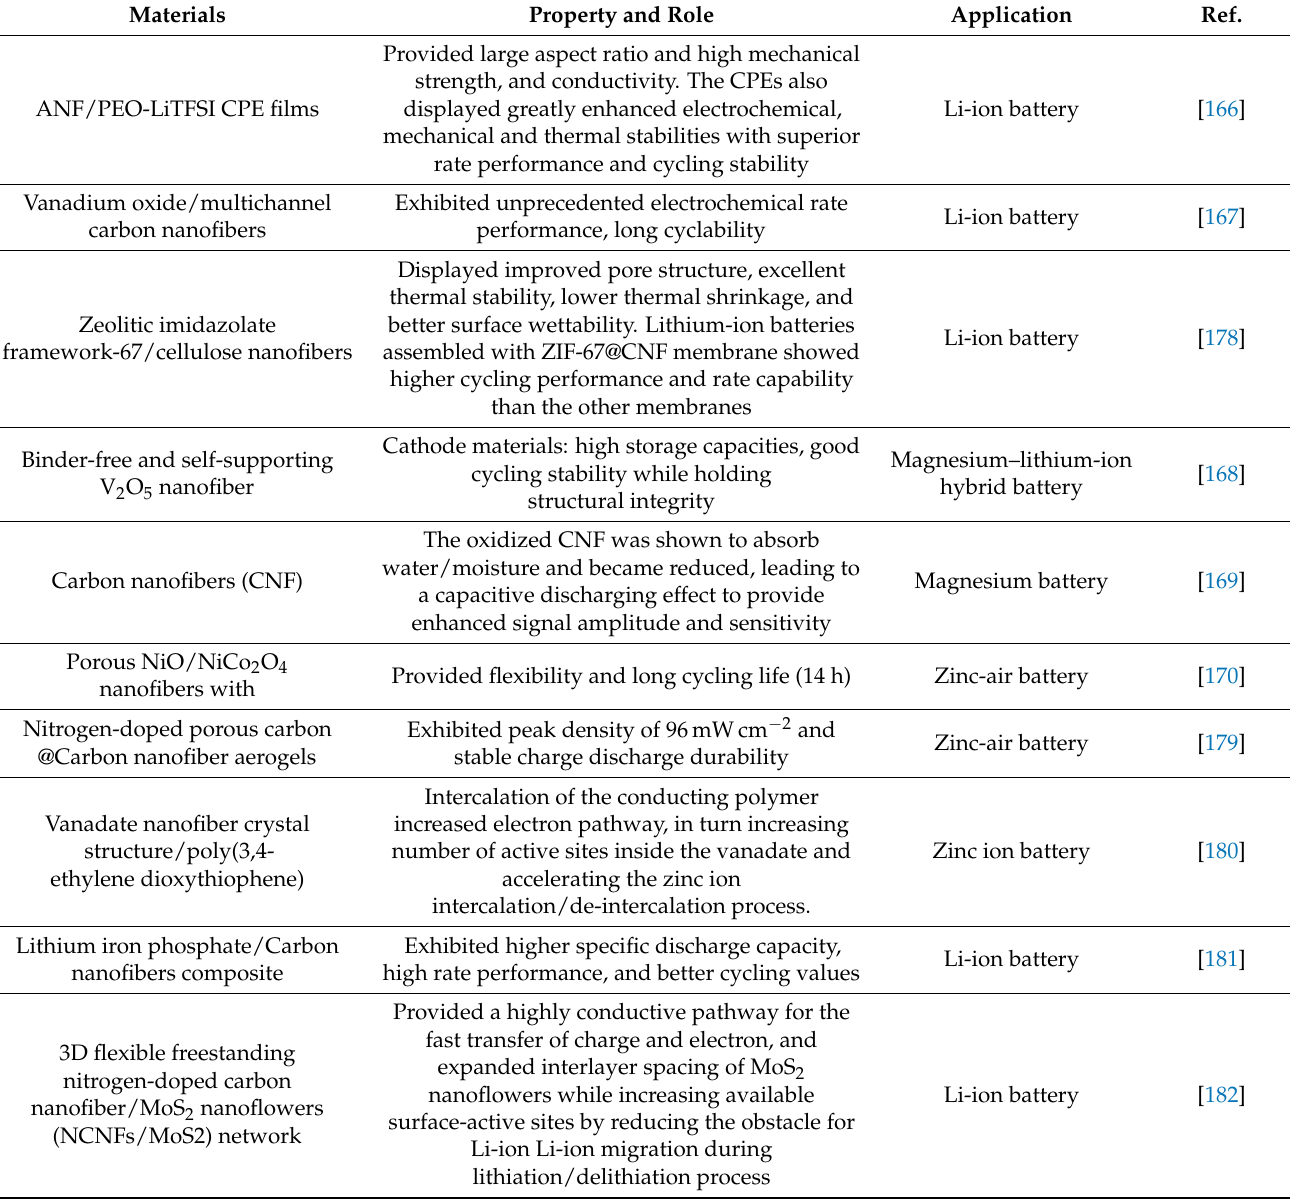
Table 5. Role of nanofiber materials in various battery and super capacitor